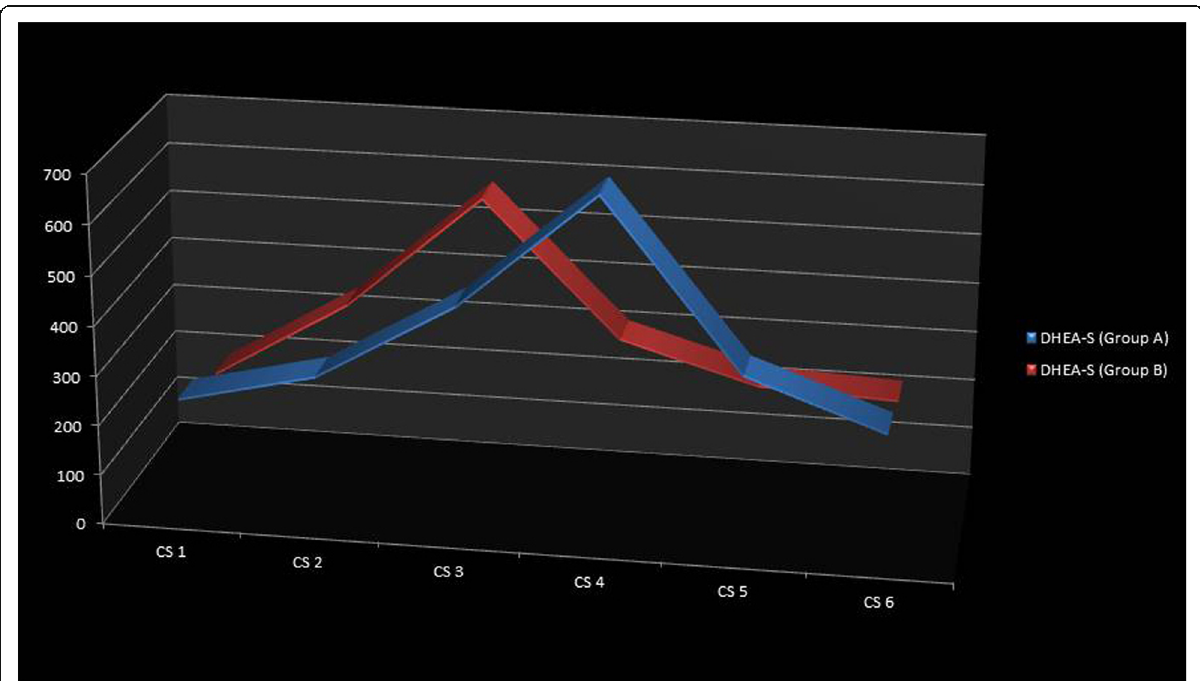
Fig. 2 Serum DHEA-S levels in each CS stage in group A and group